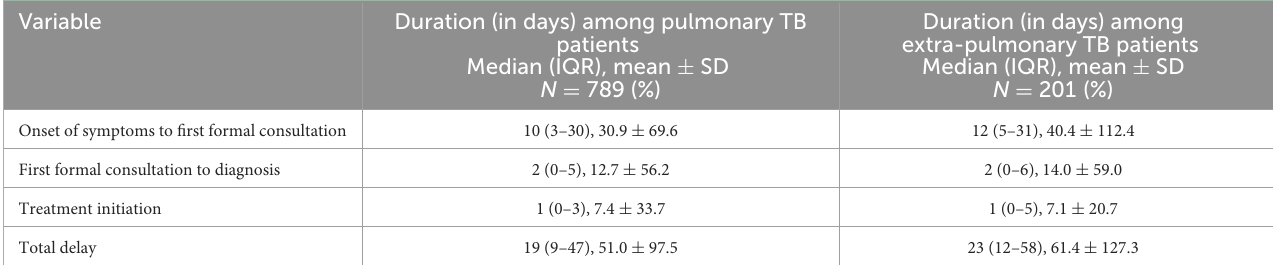
TABLE 2 Duration of the care-seeking at the various phase of the care cascade among surveyed TB patients in two Indian states Jharkhand, Gujarat during Jan–Jul 2021.